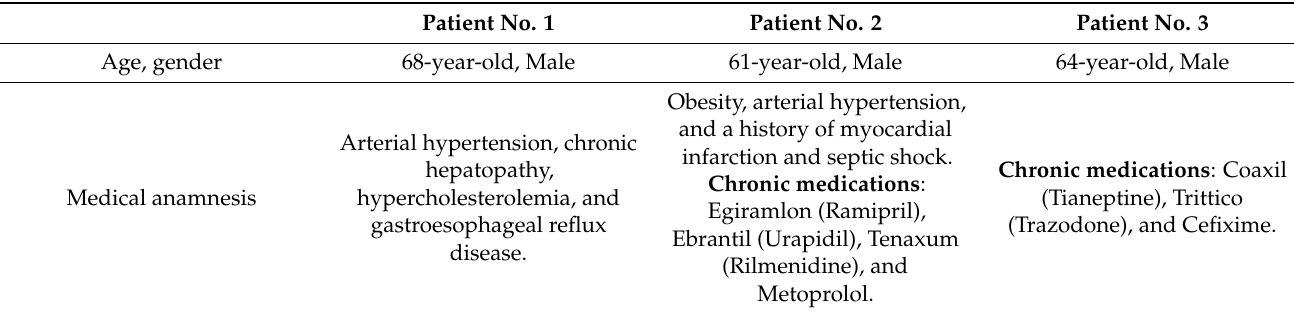
Table 1. Critically ill COVID-19 patients at F.D. Roosevelt Teaching Hospital (SK)—8 December 2020. Patient No.